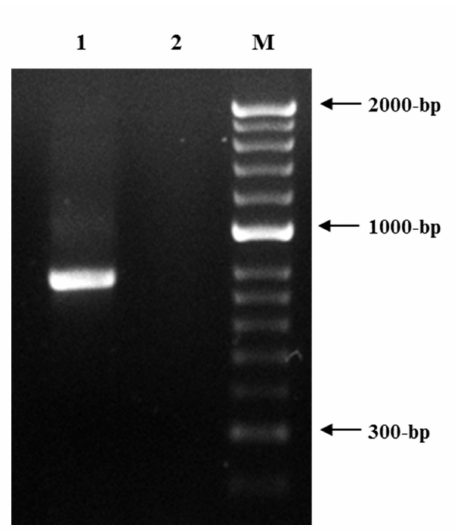
Figure 3. DNA amplification product obtained from Helicotylenchus dihystera isolate identified on Ficus microcarpa to the D2D3 expansion region of the 28S rDNA gene (1). 2, negative control. M, DNA marker (HyperLadder II; Bioline).